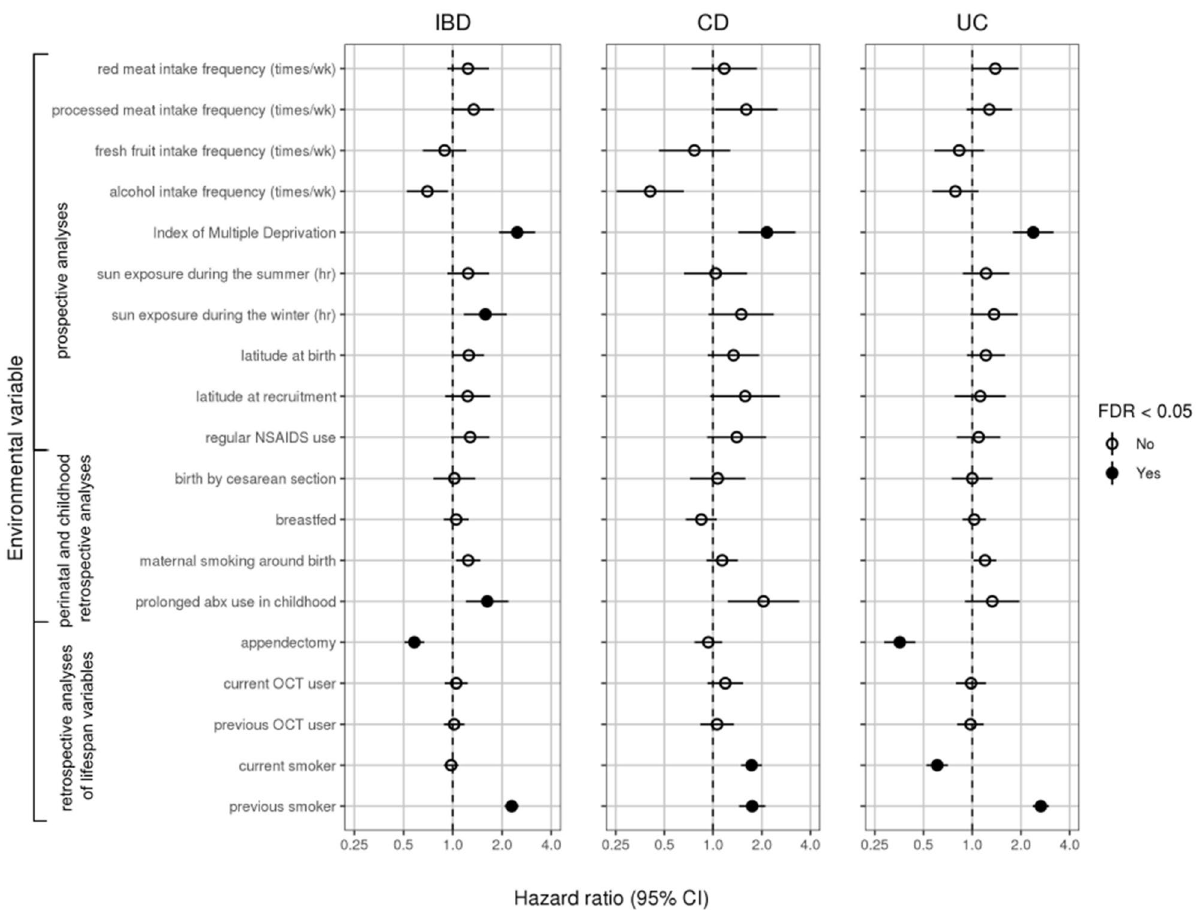
Figure 4. Forest plot of hazard ratios (dots) and 95% confidence intervals (lines) obtained from Cox regressions. Hazard ratios were adjusted for other covariates, including polygenic risk. Statistically significant results (FDR < 0.05) represented by filled circles. For continuous variables, hazard ratios are given per standard deviation of the variable. For binary variables, raw hazard ratios are given. Results for 24-h dietary variables are shown in Supplemental Fig. 3. Results for hormone replacement therapy not displayed because they did not meet the proportional hazards